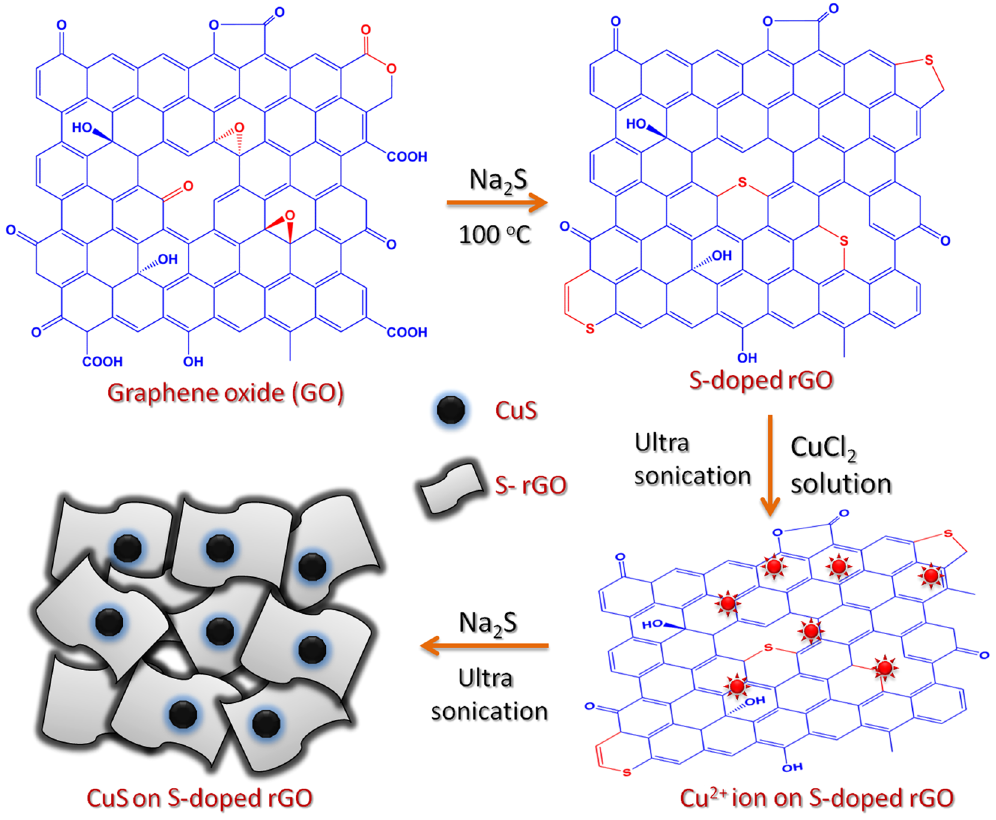
Figure 2. The schematic view of the overall sonochemical synthesis procedure for the preparation of S-rGO/ Further, the peaks at 1195, 900 and 580 cm − 1 are corresponds to the vibrations of C–S–C, C–S and C–C = S 27, 28 . This result was supported to the formation of S-rGO accompanied with XPS analysis. From the above results, we attempt to propose a mechanism for the formation of S-rGO. Conversely, the signal for C–O–C bonding was absent in S-rGO, which stated that the epoxide group of GO might be converted into C–S–C or C–S. Moreover, the carbonyl group was highly electrophilic nature than that of other oxygen functionalities. Hence, the S 2 − ions (from Na 2 S) attack the epoxide group or carbonyl group by the neculeophilic substitution which is the key step in the formation of S-rGO (the possible reactive groups and products are marked as red in Fig. 2). The oxidation state of Cu and S in the as-prepared bulk CuS was analyzed by XPS. The high resolution XPS spectra of the Cu 2p and S 2p core levels for the CuS (covellite) was displayed in Fig. 3A,B. The high resolution Cu 2p spectrum of the CuS was revealed the binding energies at 932.4 eV and 952.4 eV corresponding to the Cu 2p 3/2 and 2p 1/2 . The Cu 2p 3/2 spectrum of CuS (covellite) revealed a single peak at 932.4 eV for the single oxidation state of Cu (I), which are in good accordance with previously published values for Cu (I) 6 . Further, the high reso- lution S 2p spectra of CuS is distinguished by three typical peaks of CuS. The Gaussian fitting profile reveals that there are distinct S sites in the CuS. The signals at 161.8 and 162.7 eV attributed to the S 2 − and S 22 − , respectively 6 . This result was confirmed that the sulfur was present as two chemical environment viz., trigonal bipyramidal and disulfide bridge in CuS (Fig. 1). The Cu-S bonding characteristics were further confirmed by FT-IR analysis. Figure 4B displays the FT-IR spectrum of CuS (a), where the peak at 618.3 cm − 1 is corresponding to the stretching vibrations of Cu-S 29 . From the XRD patterns, we clearly confirmed the formation of CuS, which exhibited that the CuS was crystallized in hexagonal close packing (hcp) system with the space group of P63/mmc (Fig. S4). The observed peaks are well matched with the reference pattern (JCPDS no. 79–2321) and there is no impurity peaks were observed 30 . These results are confirmed that the CuS was successfully synthesized by sonochemical process and the structural characteristics are strongly resemblance to the reported results of CuS (covellite). Afterwards, the CuS was synthesized accompanied with S-rGO by sonochemical process. Interestingly, the S-rGO was consid- erably changing the structural behavior of CuS and that was highly electrochemically active towards the glucose oxidation. In order to confirm the structural transformation of the as-prepared S-rGO/CuS, the sequence of physical characterization was examined. At first, the XRD analysis was evaluated to investigate the structural behavior of the S-rGO/CuS. Unfortunately, the XRD patterns didn’t show any considerable changes from the bulk CuS (covellite). The obtained diffraction peaks (2 θ ) at 27.7, 29.3, 31.8, 32.8, 48.0, 52.7 and 59.3 are attributed to the (101) (102) (103) (006) (110) (108) and (116) where the additional peak appeared at 26.5 (2 θ ) corresponds to the S-rGO. Hence, the as-prepared S-rGO/CuS was clearly matched with the bulk CuS (covellite) (Fig. S5). Then, the